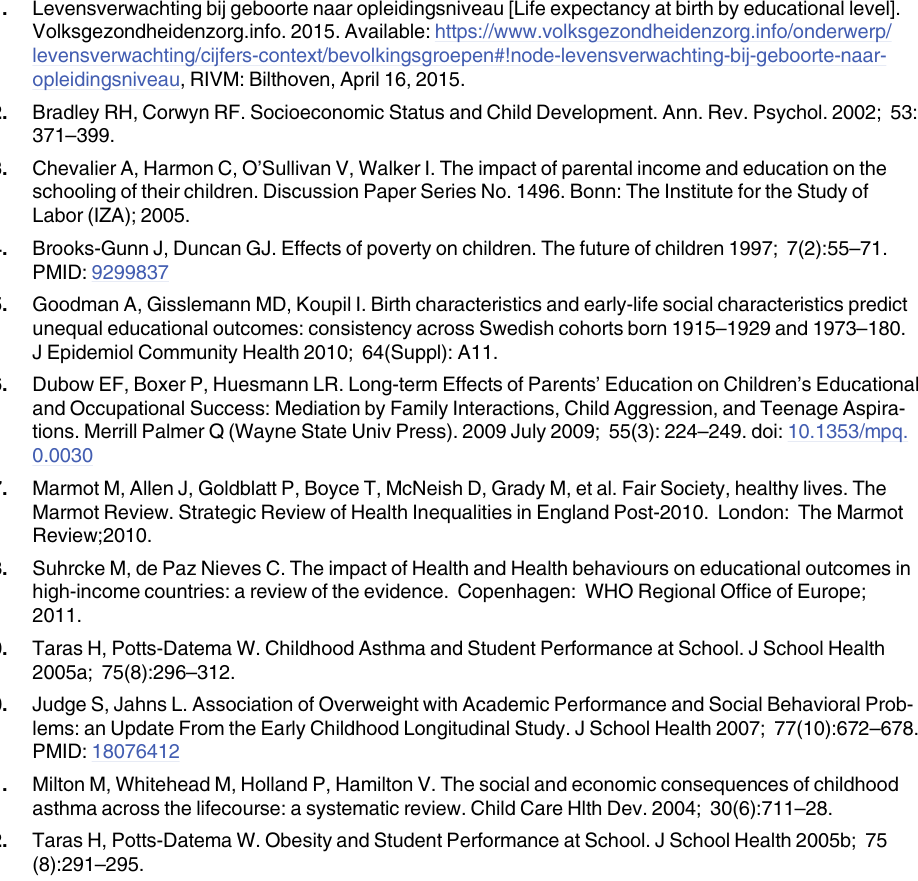
S1 Table. Results complete case